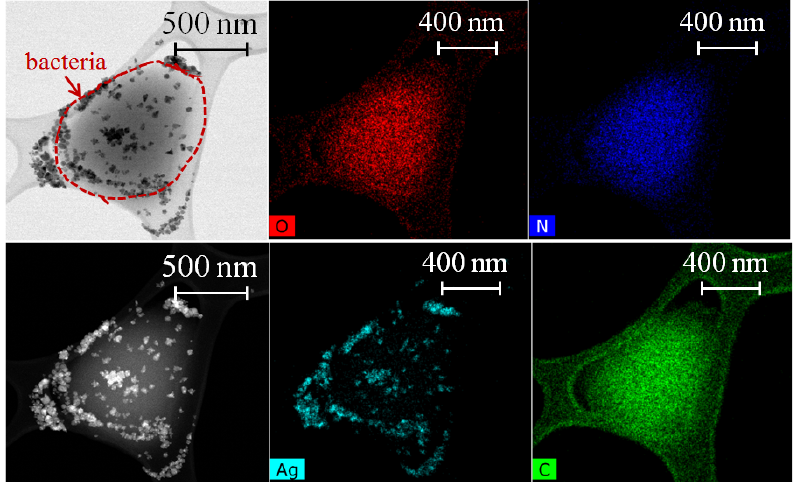
Figure 5. TEM image of S. aureus cells after treatment with Ag NPs colloid (concentration 1 mg/mL), distribution of elements in the sample, acquired by EDS and HAADF image.